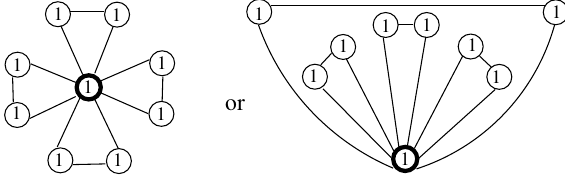
Figure 15: The zonal plane graph D 4